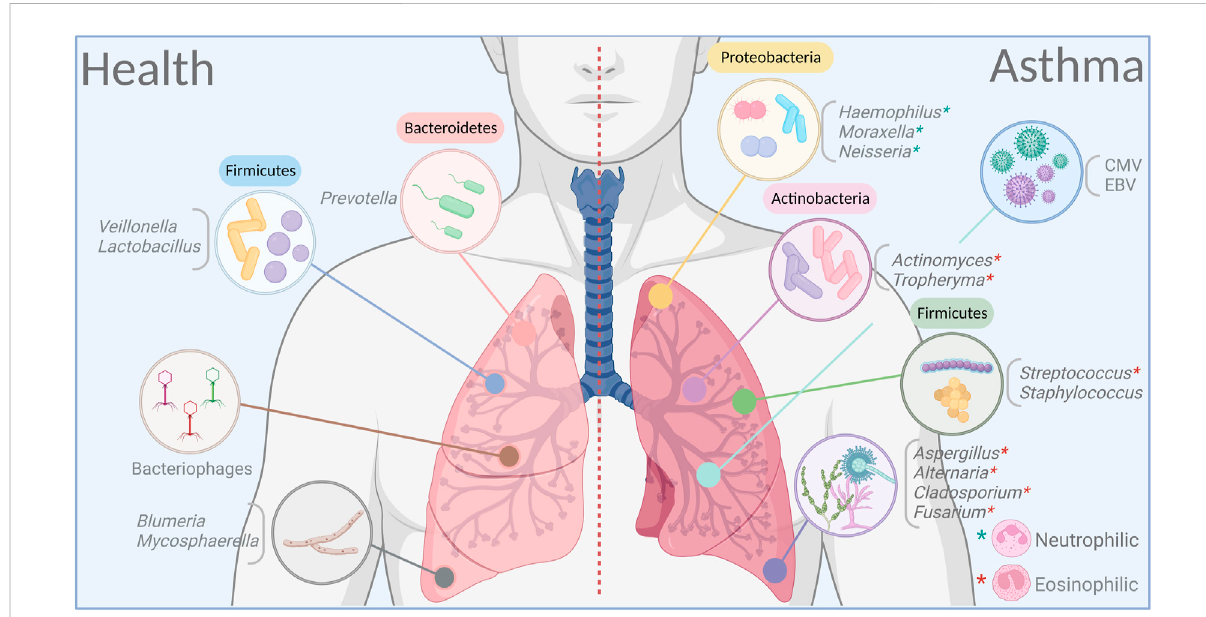
FIGURE 1 Dominant bacteria, viruses and fungi in the airways in health and asthma. Certain microbial families dominate in lungs on healthy individuals to maintain a balance between varying ecosystems and remain in a symbiotic relationship with the host. This balance is rapidly broken during